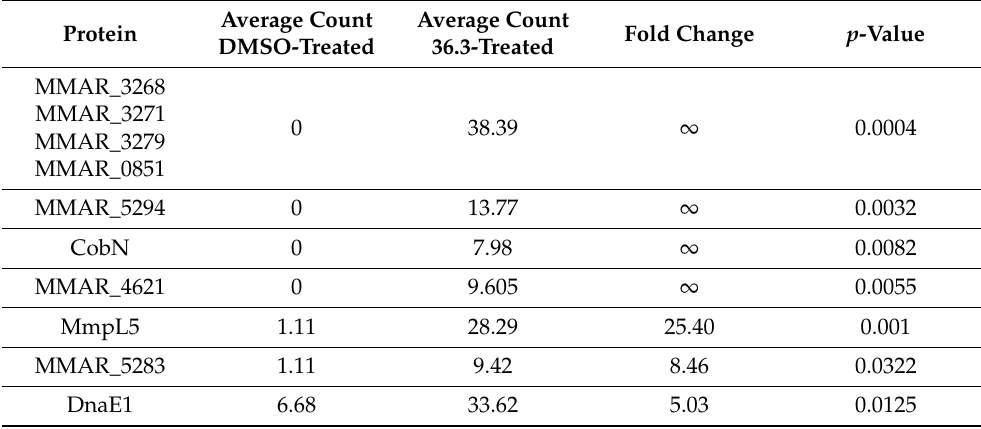
Table 1. Proteins above 130 kDa that were more abundant in the supernatant fraction of com- pound 36.3-treated M. marinum as compared to DMSO treated- M. marinum ( p -value < 0.05 and fold change >1). Average Count Average Count Fold Change p Protein DMSO-Treated 36.3-Treated